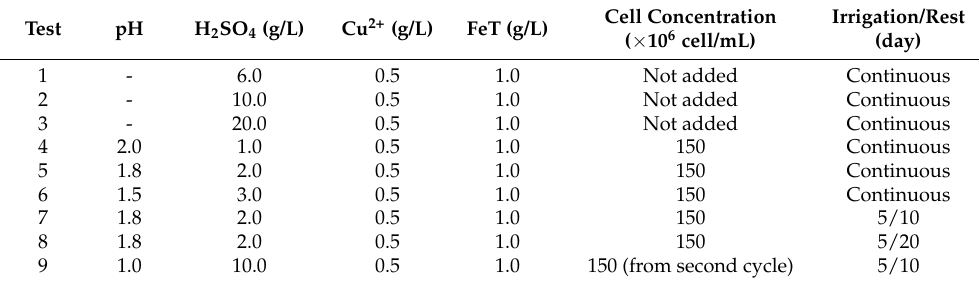
Table 3. List of tests performed on the chalcopyrite ore using columns 0.45 m in height.